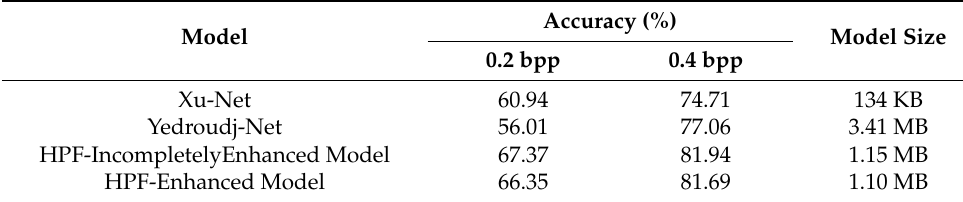
Table 5. Comparison results of